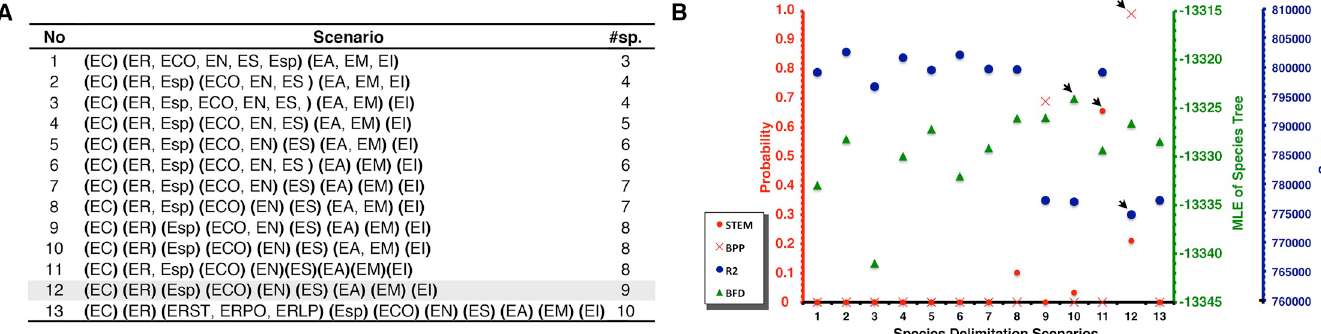
Fig 4. Multi-locus species delimitation analyses. A) species delimitation scenarios. Specimens were assigned to the delimited species indicated in Fig 3. Abbreviations within parenthesis indicate the grouping tested in each scenario. E . roseus : ER, E . migueli : EM, E . insularis : EI, and E . calcaratus : EC, E . altor : EA, E . contulmoensis : ECO, Eupsophus sp.: EV, E . nahuelbutensis : EN, E . septentrionalis : ES. Some abbreviated localities from S1 Table were added to species abbreviation to indicate a specific locality grouping. The most congruent scenario is indicated in gray. B) probability, marginal likelihood (MLE), or score values generated for each scenario using different species delimitation approaches. Black arrow indicates the credible species hypotheses. For Tr2 lowest score indicates the better-delimited scenario. For STEM and BFD were plotted model probabilities and MLE values using stepping-stone sampling, respectively (see S4 and S5 Tables).